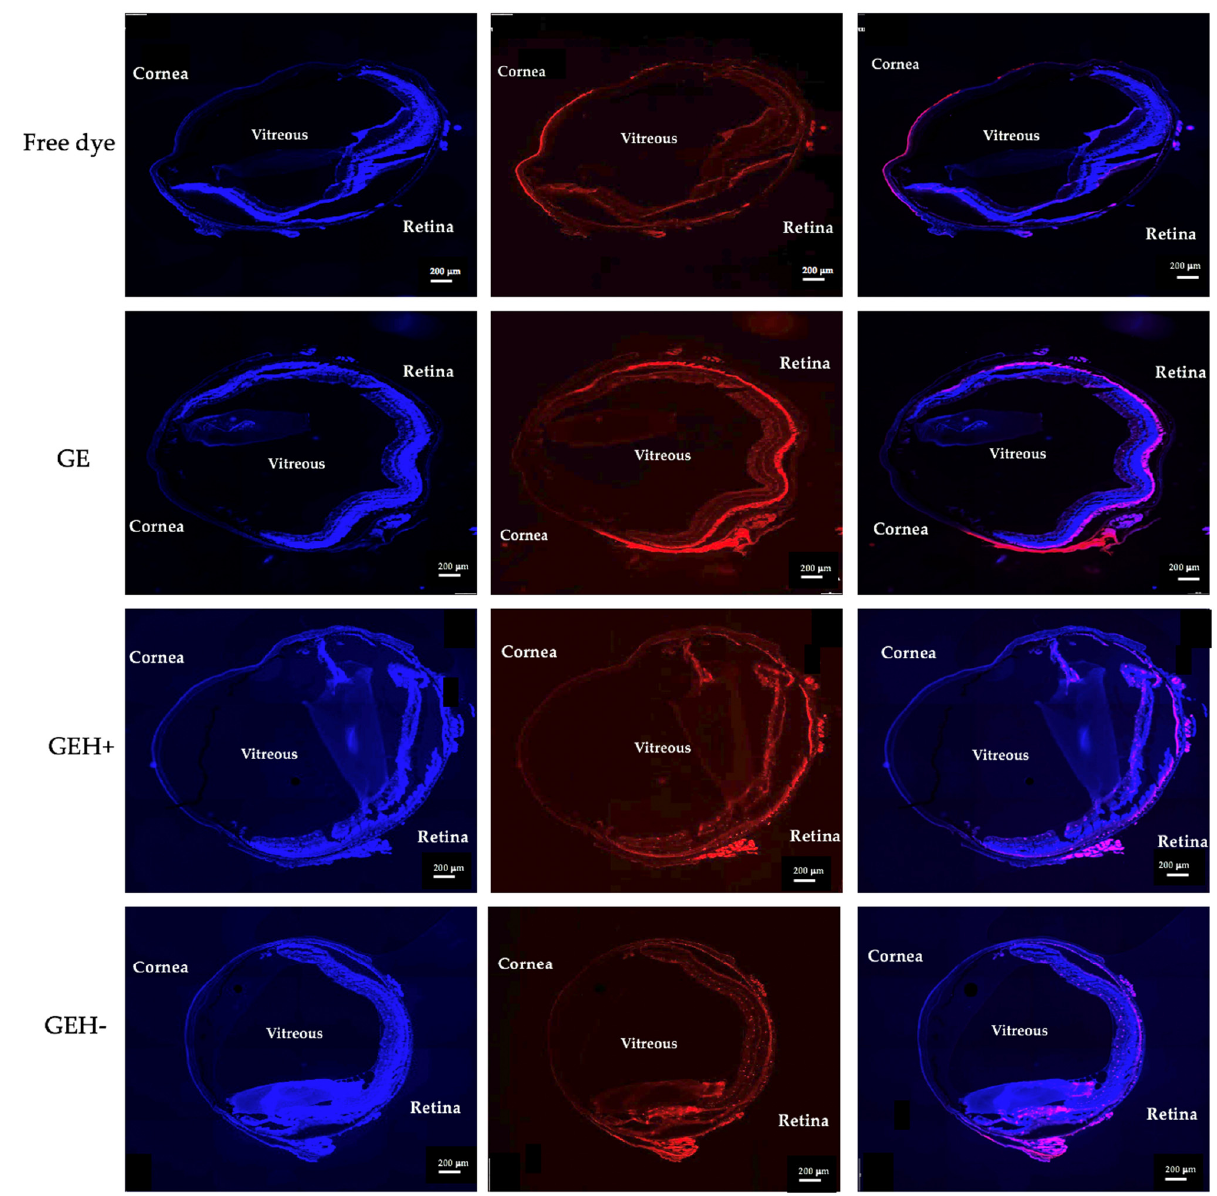
Figure 7. Fluorescent images of whole eyeball sections treated by different nanoparticles via subconjunctival injection, 30 min after injection. (scale bar: 200 µm)(Nuclear stained by DAPI in blue; dye (TAMRA)-conjugated NPs revealed in red; and the merged images).